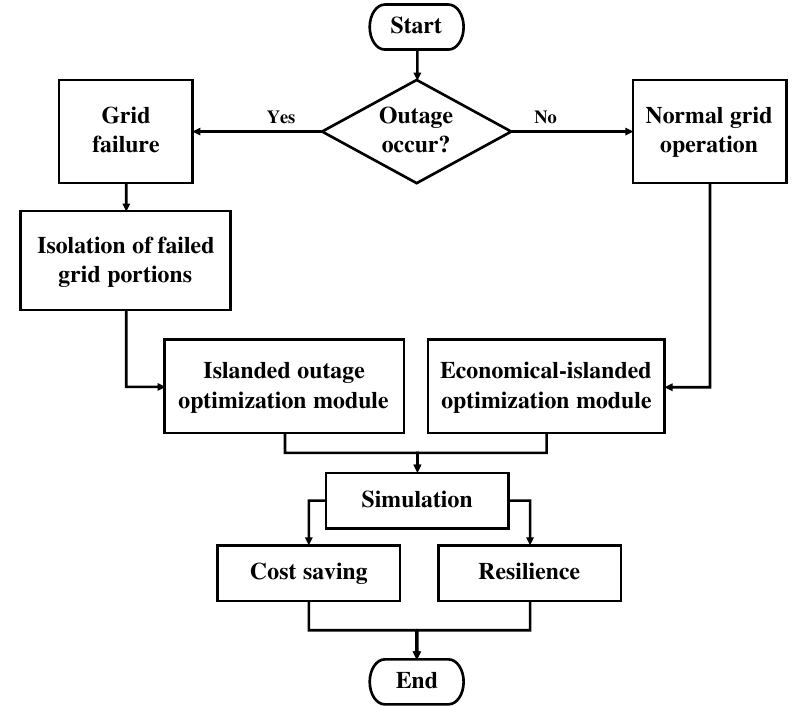
Figure 2. Flow chart describing the integration process of the proposed grid optimization